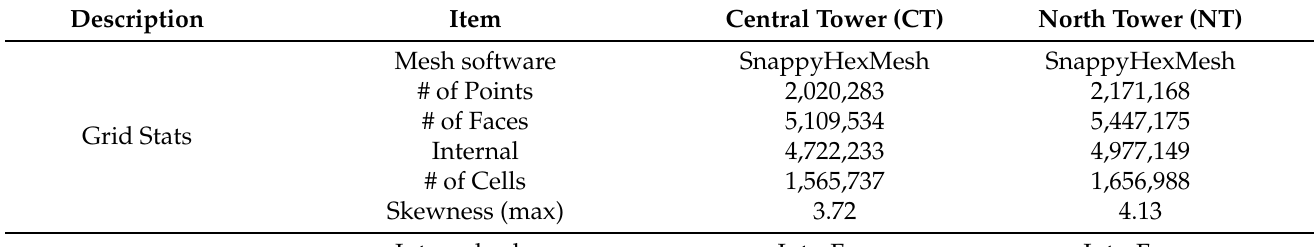
Table 1. Simulation parameters adopted in OpenFOAM for both